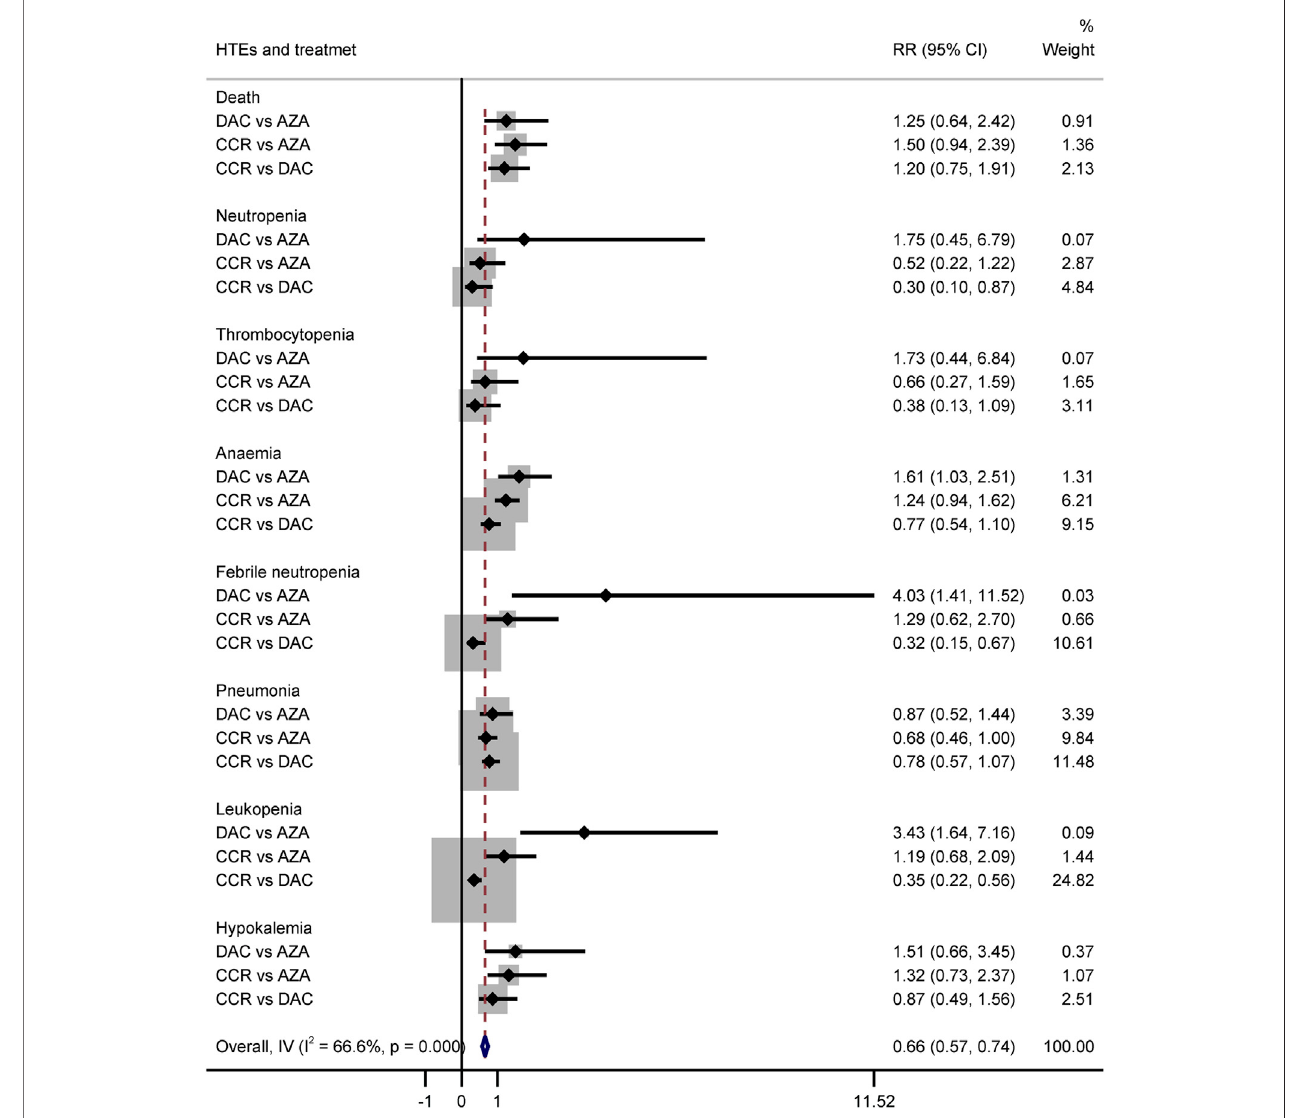
FIGURE 9 | Forest plot of grade 3/4 adverse events represents the direct and indirect comparison.